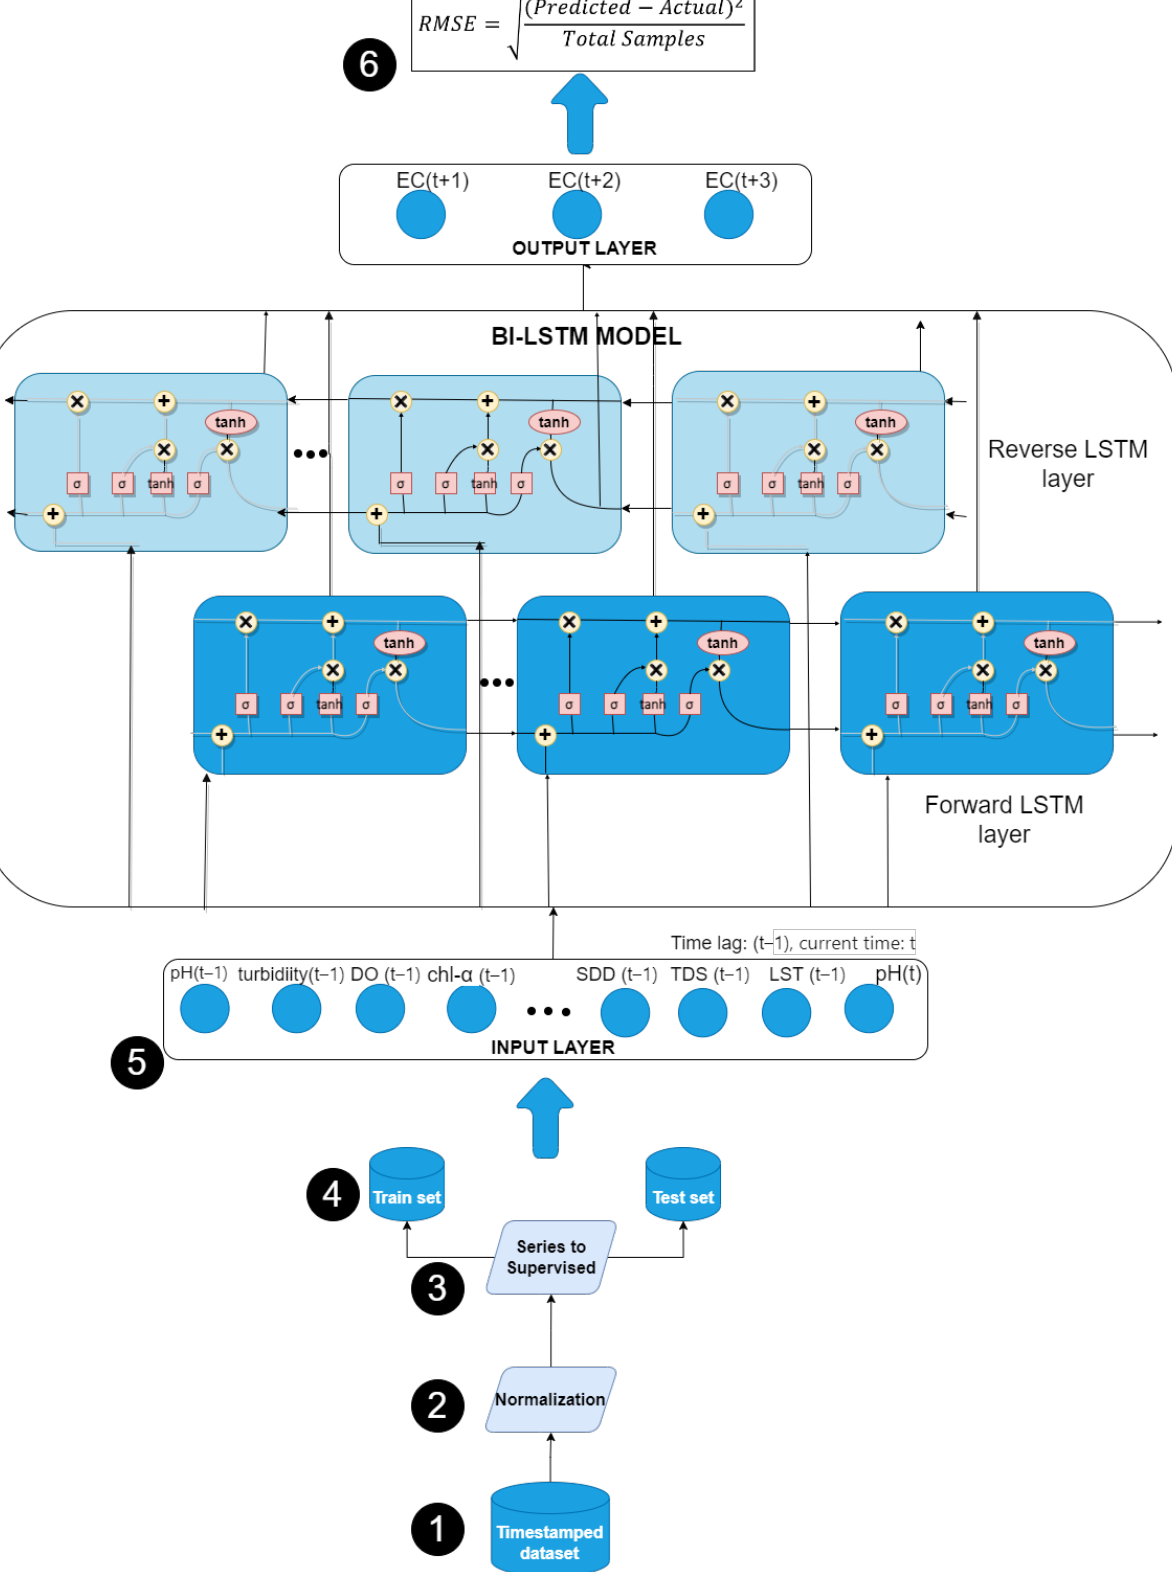
Figure 4. The architecture of the designed Bi–LSTM model, displaying the steps involved in training the deep model to predict the multi–step EC